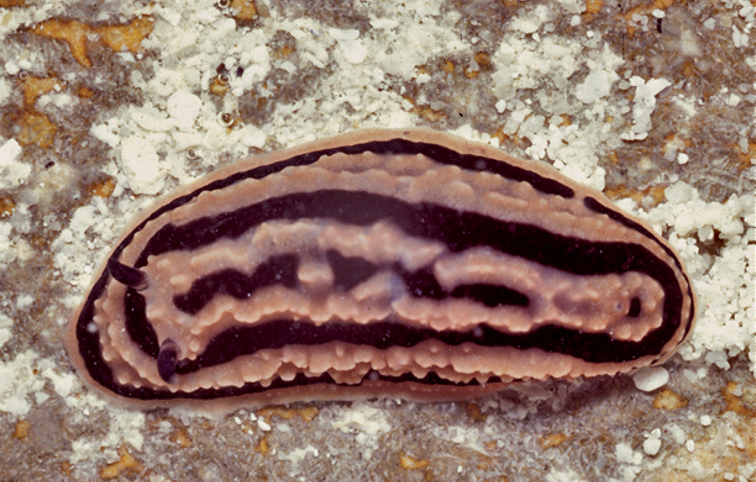
Phyllidiella zeylanica, Maldives, photo: J Hinterkircher (no spcm).